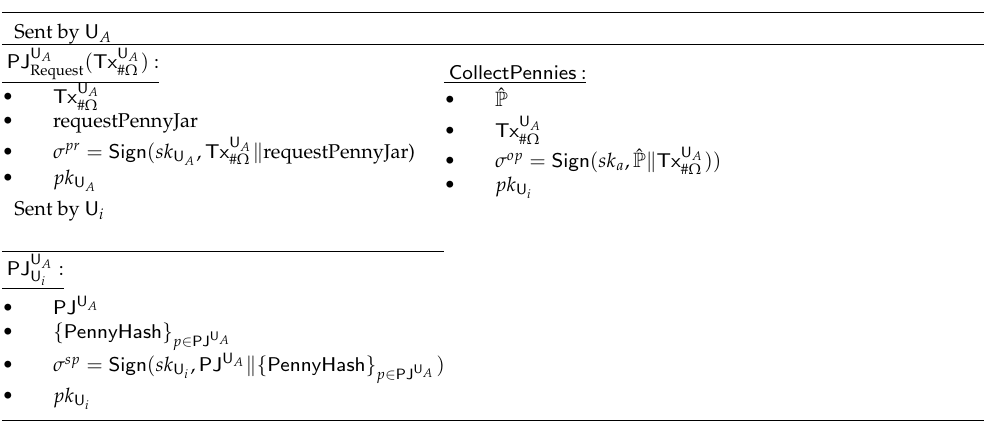
Figure 9. Dandelion penny jar request description of senders and the